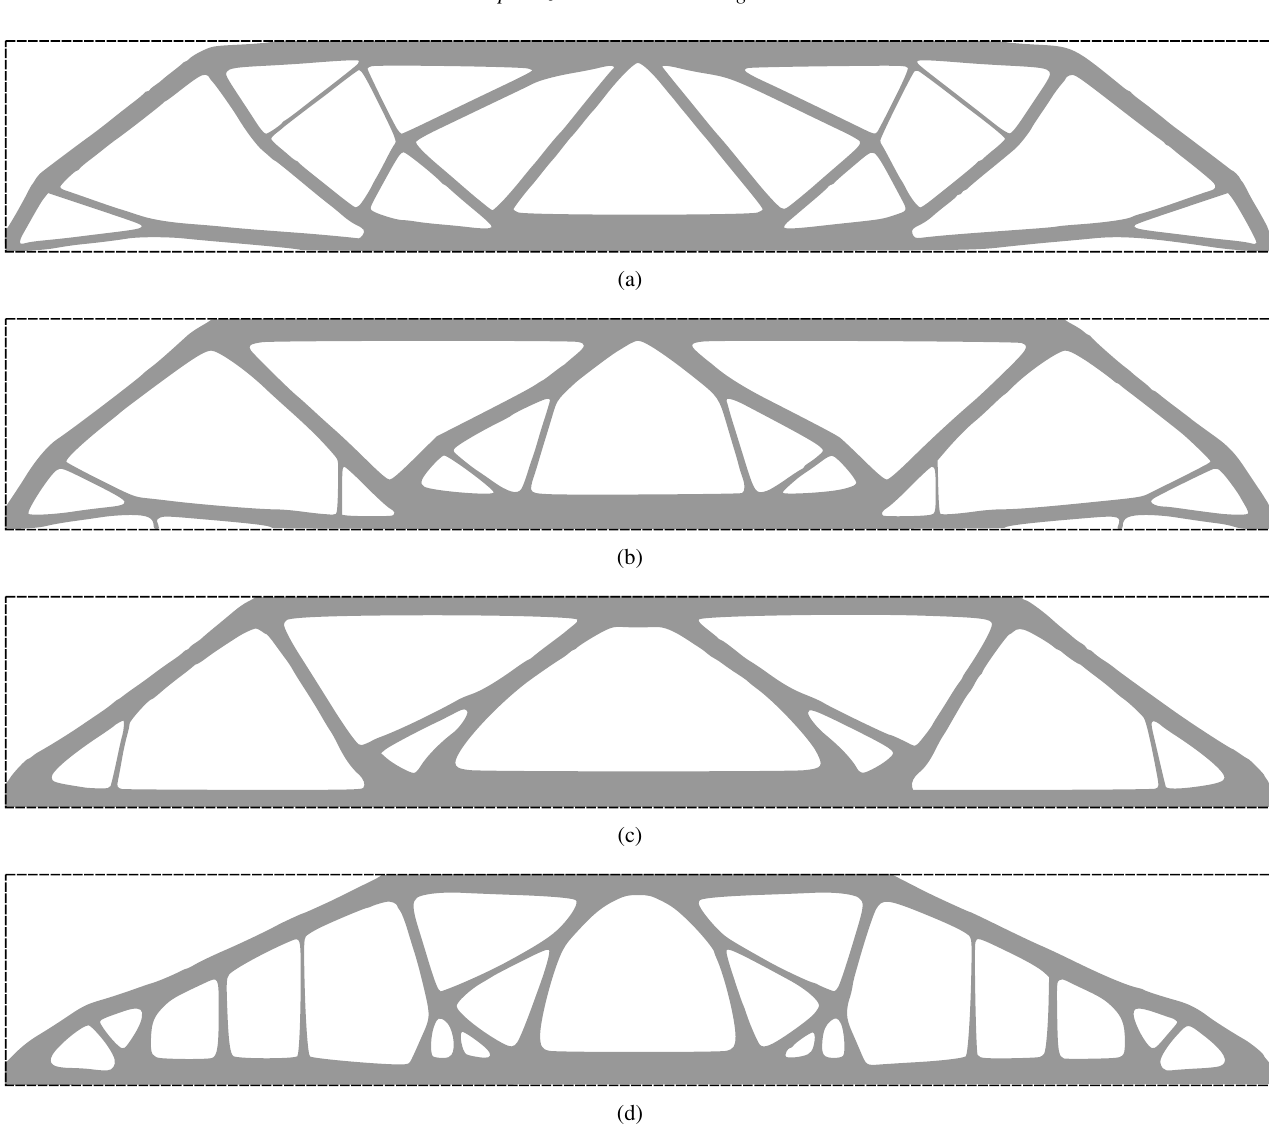
Fig. 7 Optimized shapes for the two-dimensional MBB Beam example of Section 5.3: (a) optimized shape Ω ∗ for Problem (8) (i.e. without additive manufacturing constraints), and optimized shapes for Problem (29) using parameters (b) α c = 0 . 50 , (c) α c = 0 . 30 , and (d) α c = 0 . 10